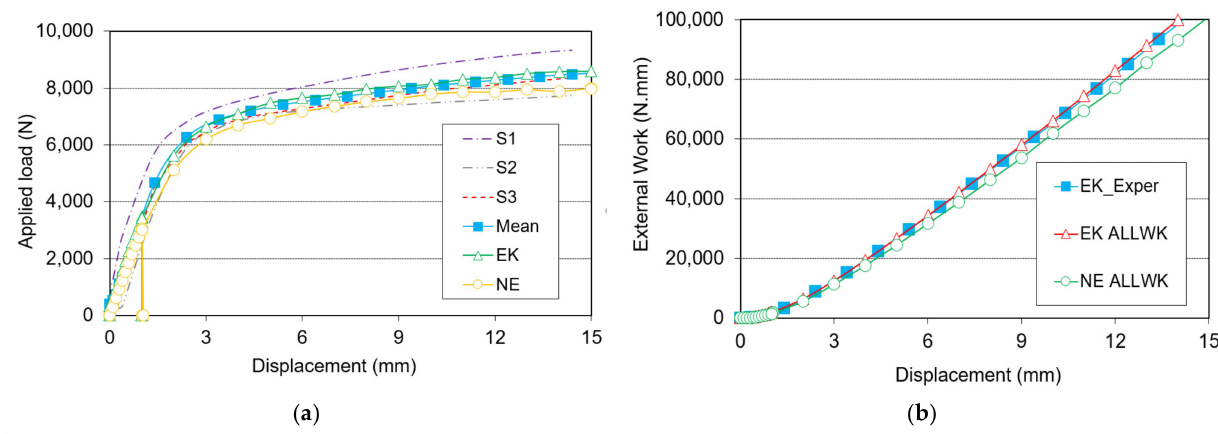
Figure 11. Comparison of finite element and experimental results. ( a ) Load vs. displacement and ( b ) external work vs.